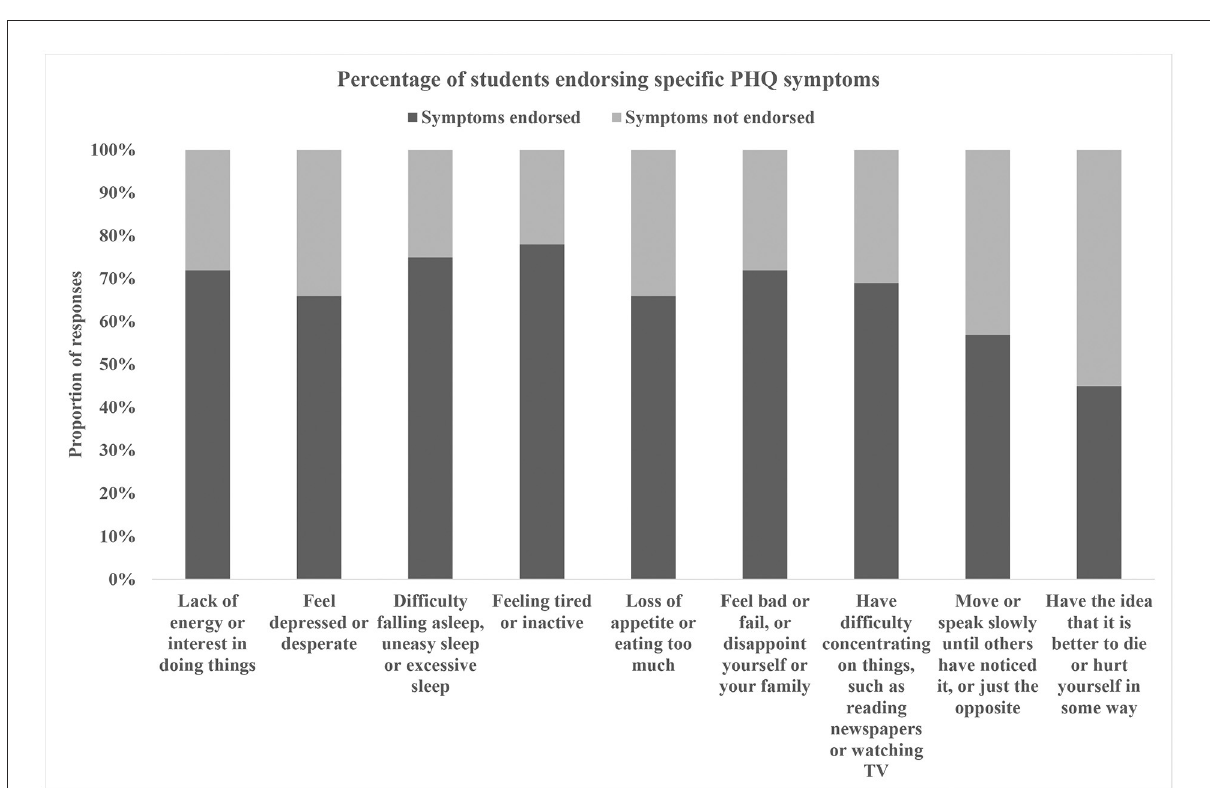
FIGURE3 The proportion of nine PHQ symptoms in depression